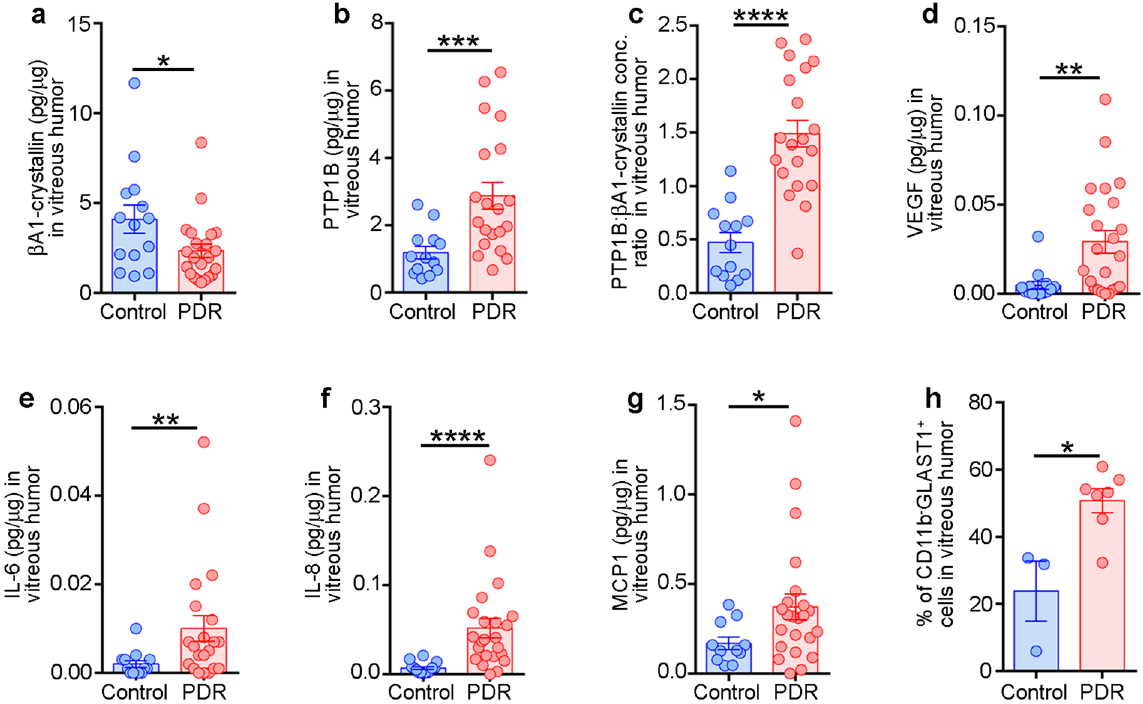
Fig. 8 Altered levels of β A1-crystallin, PTP1B, VEGF, IL-6, IL-8, MCP1, and proportion of astrocytes in vitreous humor of patients with proliferative diabetic retinopathy. Graphs indicate the concentration of a β A1-crystallin, b PTP1B, c ratio of PTP1B and β A1-crystallin, d VEGF, e IL-6, f IL-8, g MCP1, and h proportion of astrocytes (CD11b − GLAST1 + cells) in the vitreous humor of patients with proliferative diabetic retinopathy (PDR) and control patients with macular hole (Control). The absolute concentration of each factor has been normalized to respective total protein concentration and represented as pg/ μ g. The sample size in panels a – g for control is n = 14 and for PDR is n = 23. The sample size in panel h for control is n = 3 and for PDR is n = 7. * P < 0.05, *** P < 0.001; **** P <